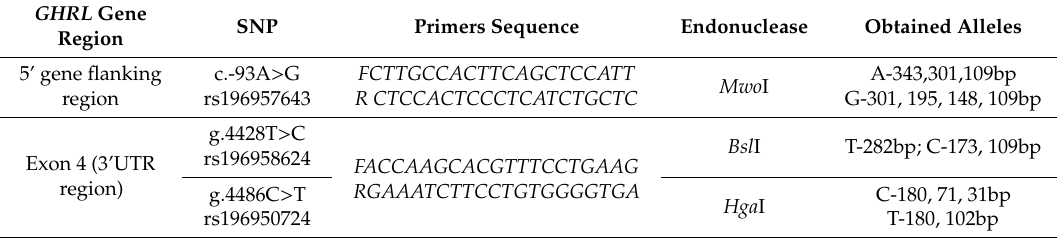
Table 2. The details of the PCR-RFLP method used to identify the polymorphisms in the ghrelin (GHRL)